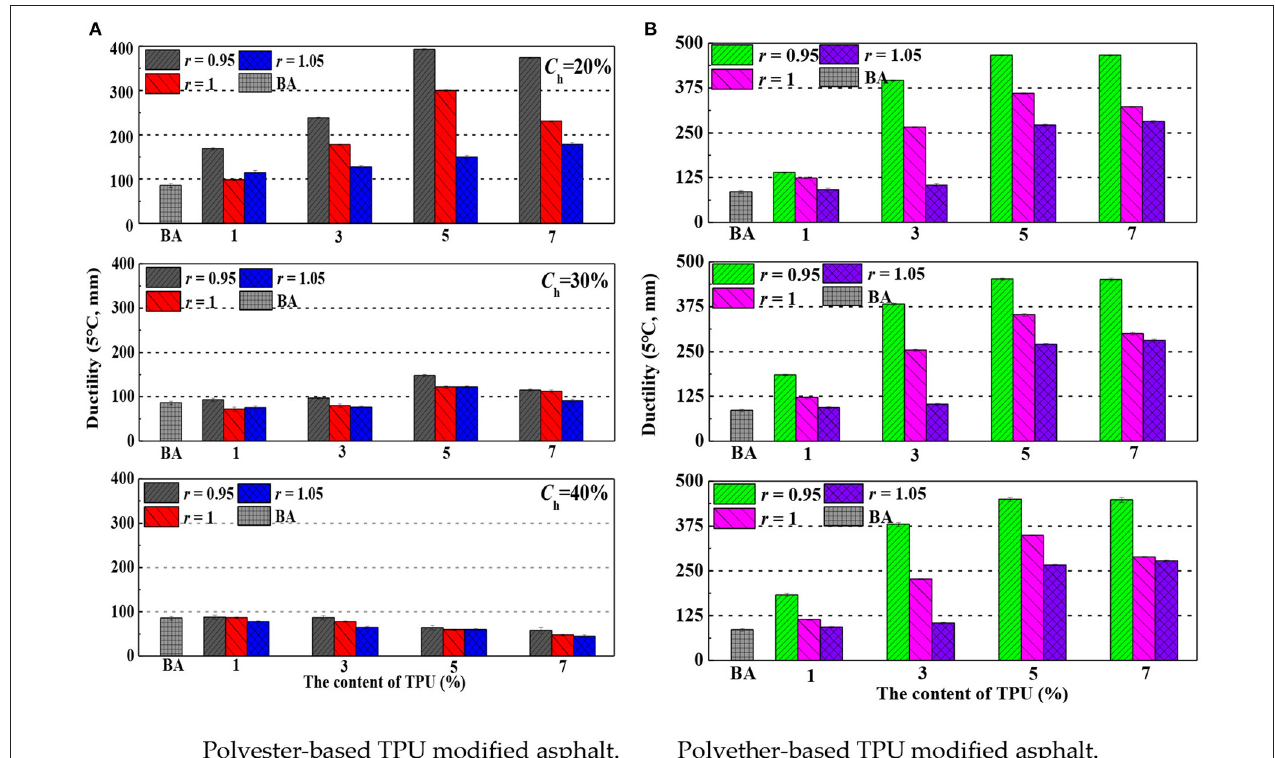
FIGURE 10 | The ductility of modified asphalt. (A) Polyester-based TPU-modified asphalt. (B) Polyether-based TPU-modified asphalt.